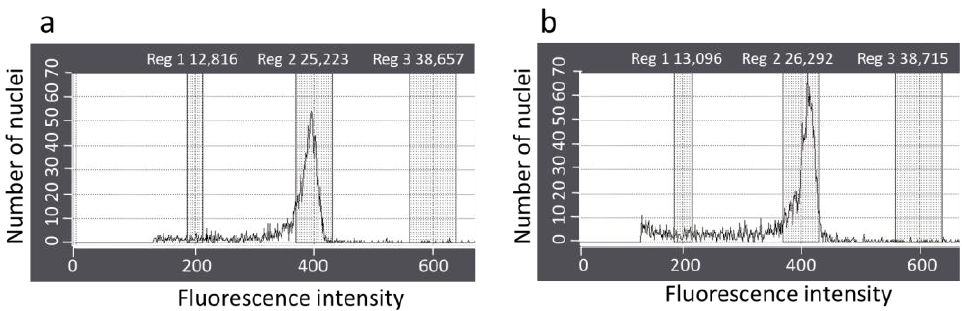
Figure 7. Flow cytometry analysis of the regenerated plants derived from IRGs and control of P. ginseng cv. Cheonryang. Histogram fluorescence intensity documenting the relative DNA content of the nuclear suspension from young roots of ( a ) regenerated plant and ( b ) control derived from seed. IGR, in vitro grown root.